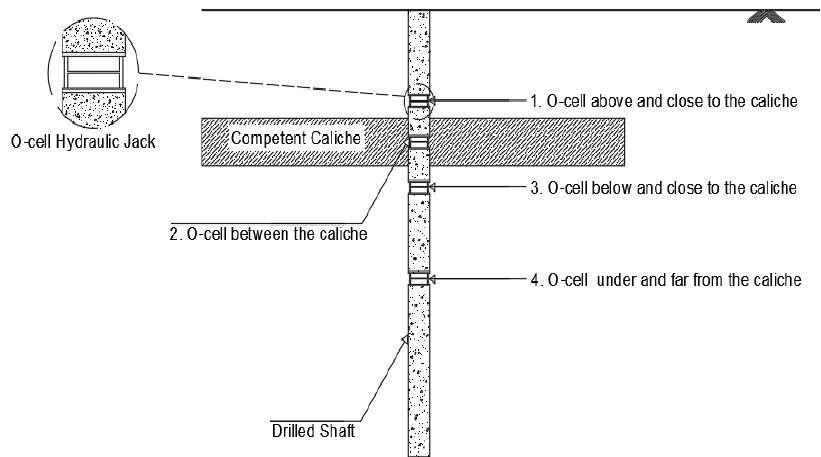
Figure 5. O-cell hydraulic jack location with respect to the existing competent caliche layer scenarios.